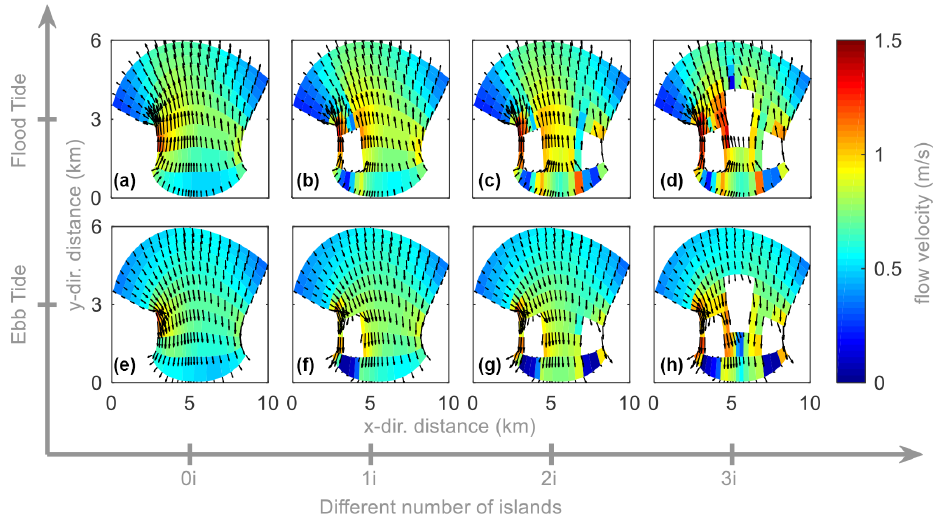
Figure 5. Flow field near the inlet: panels (a–d) represent at the time of flood tide of a basin without an island (“0i”), basin with one island (“1i”), basin with two islands (“2i”) and basin with three islands (“3i”), and panels (e–h) represent at the time of ebb tide, respectively. Arrows for flow direction and colour for depth-averaged flow velocity (m/s).